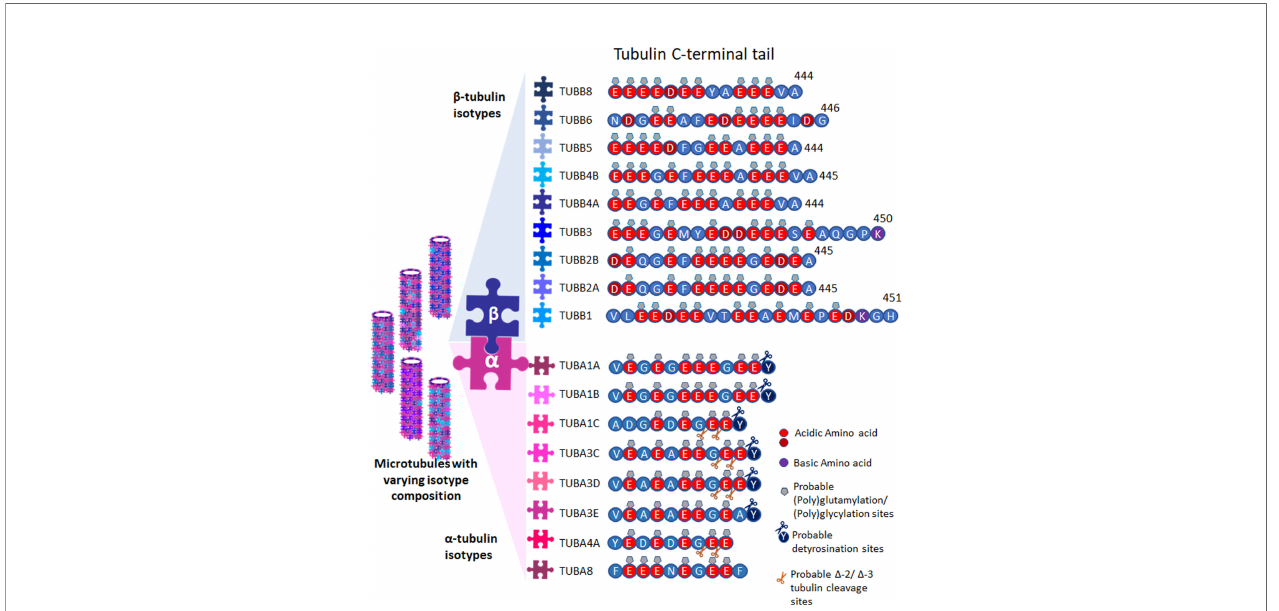
FIGURE 1 | Tubulins and their PTMs. Tubulin isotypes depicting the varying C-terminal sequences, showing probable post translational modi fi cation sites. Microtubules are formed with varying isotype composition.